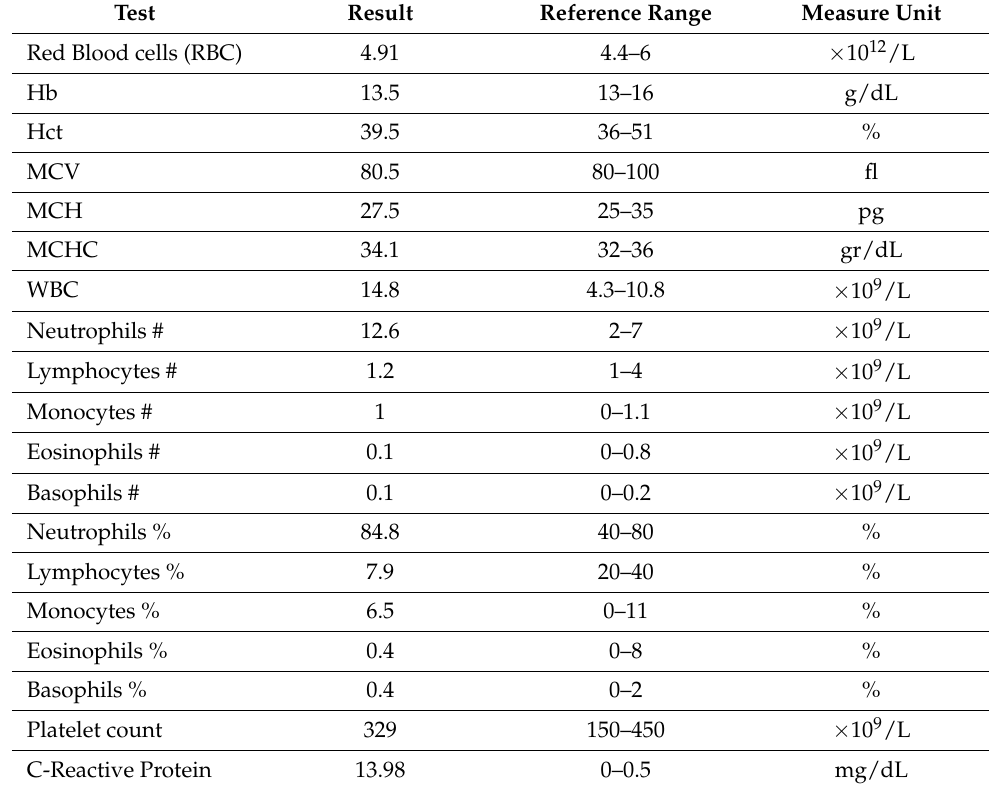
Table 1. Blood test performed in the emergency